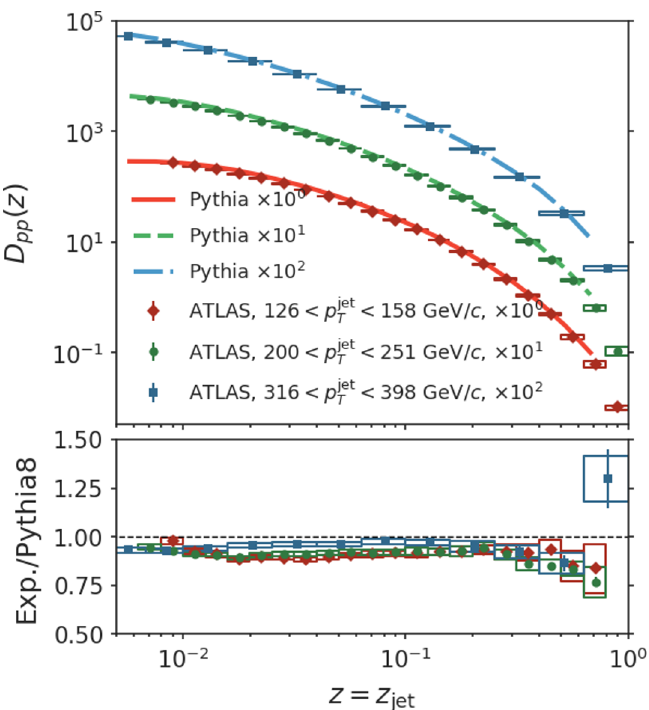
Figure 9 . Comparison of charged particle fragmentation function of inclusive jets obtained by Pythia8 simulation to data from the ATLAS experiment [108]. Ratio of experiment to simulation is shown in the lower